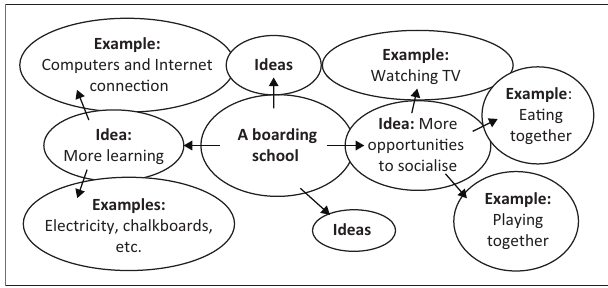
FIGURE 1: An example of a cluster in the redesigned TABLE 2: Redesigned section on writing pedagogy, with examples on feedback and clustering process. Variable